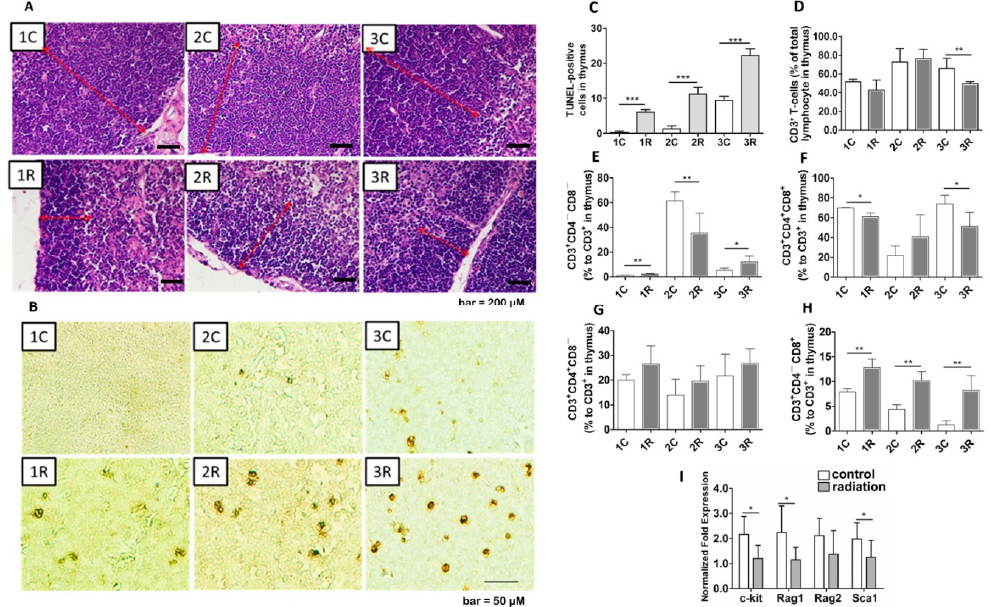
Figure 3. Shrinkage, cell apoptosis, and disordered T-cell development in the thymus of irradiated rats. ( A ) Thymic cortical thinning in irradiated rats. The red lines indicate the thymic cortex (bar = 200 μ M); ( B ) Apoptotic cells in the thymus (bar = 50 μ M); ( C ) Quantitation of terminal deoxynucleotidyl terminal deoxynucleotidyl transferase dUTP nick end labeling (TUNEL)-positive cells in the